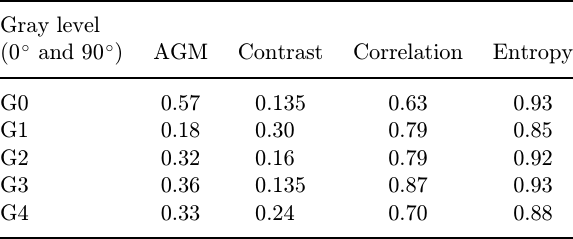
Table 1. The texture features at angels 0 (cid:1) and 90 (cid:1) .